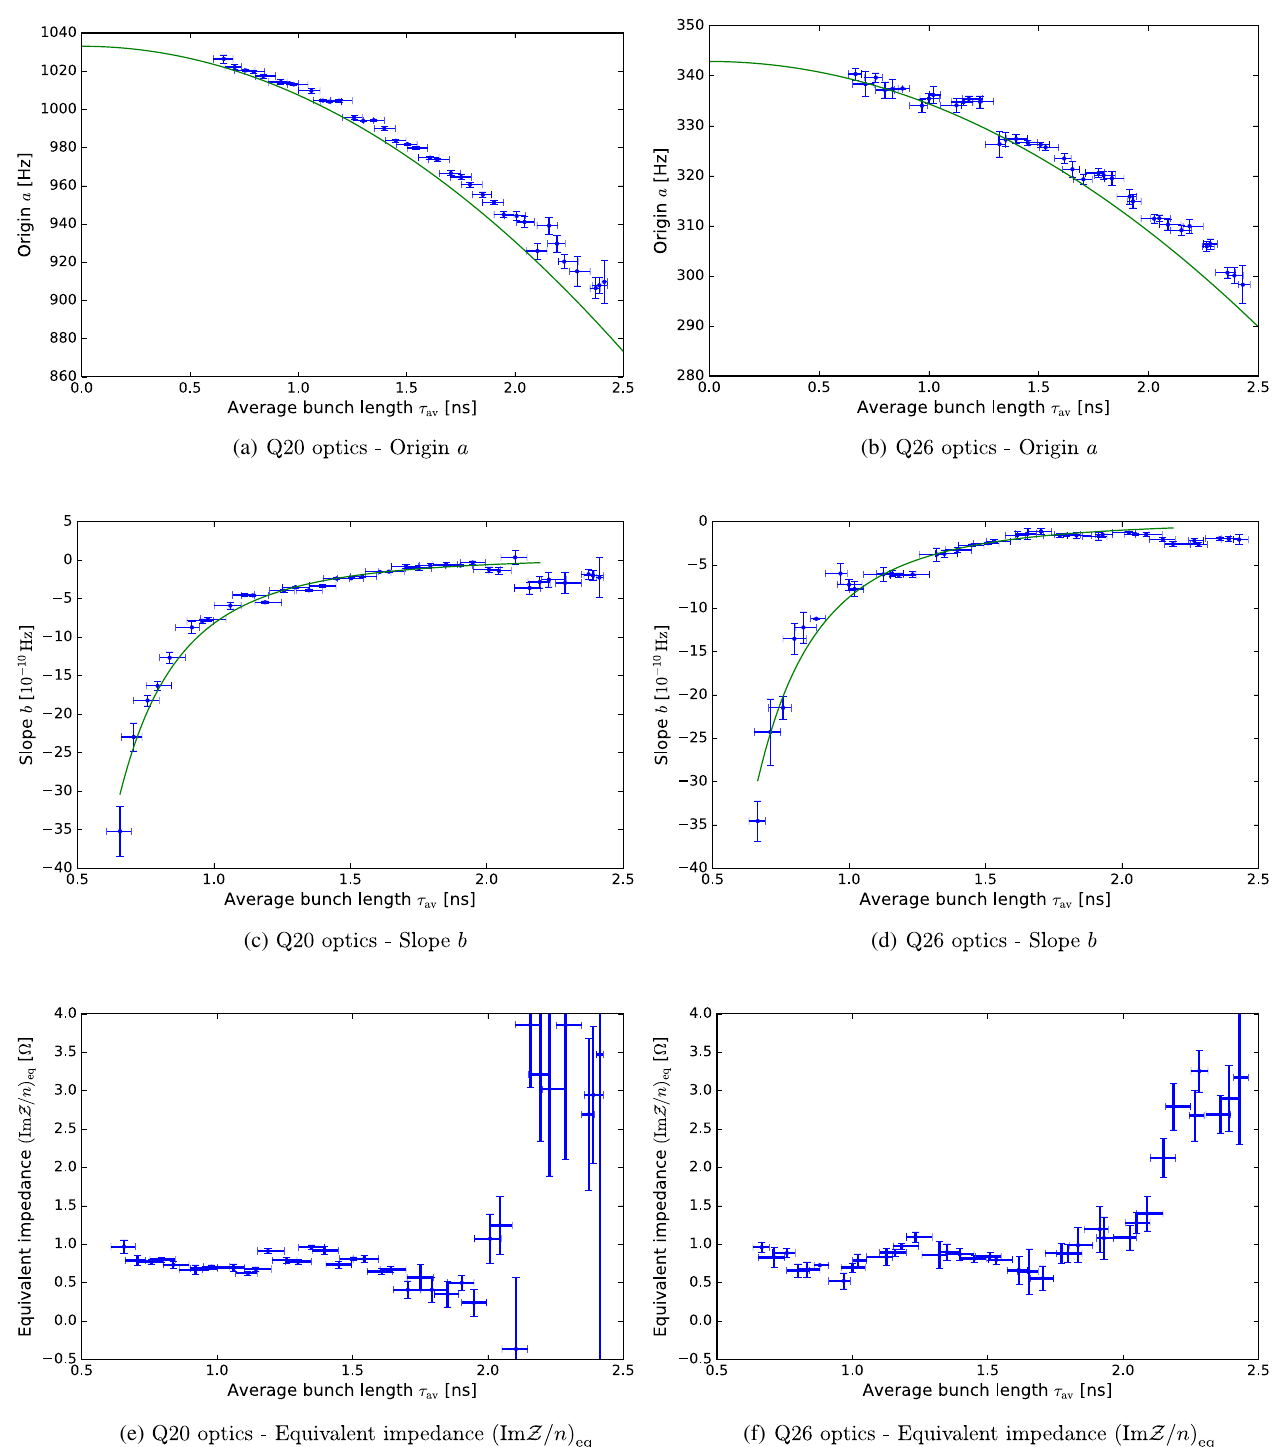
FIG. 14. The fitted origin a (top), slope b (middle) and their expected scaling (green), from Eqs. (4) and (19). The Eq. (26) was used to obtain the corresponding equivalent impedance ð Im Z =n Þ (bottom) of the quadrupole frequency shift with intensity, as a function of the eq average bunch length τ , in the Q20 (left) and Q26 (right) av